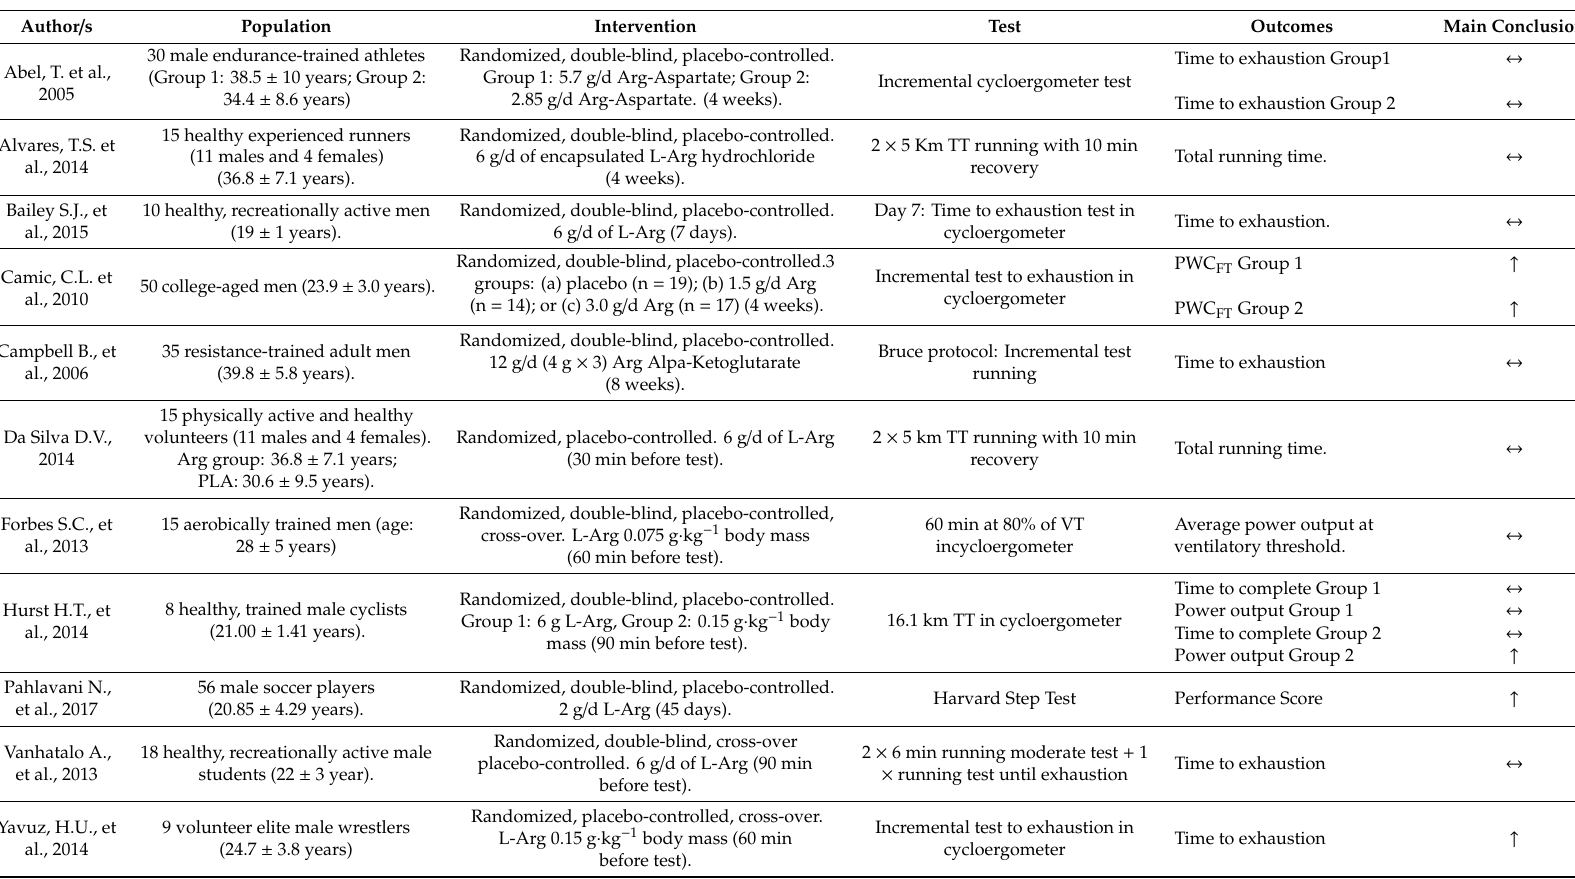
Table 3. Summary of the studies included in the systematic review that investigated the e ff ect of L-Arginine on ≤ VO 2 max performance (test lasting 5 min or